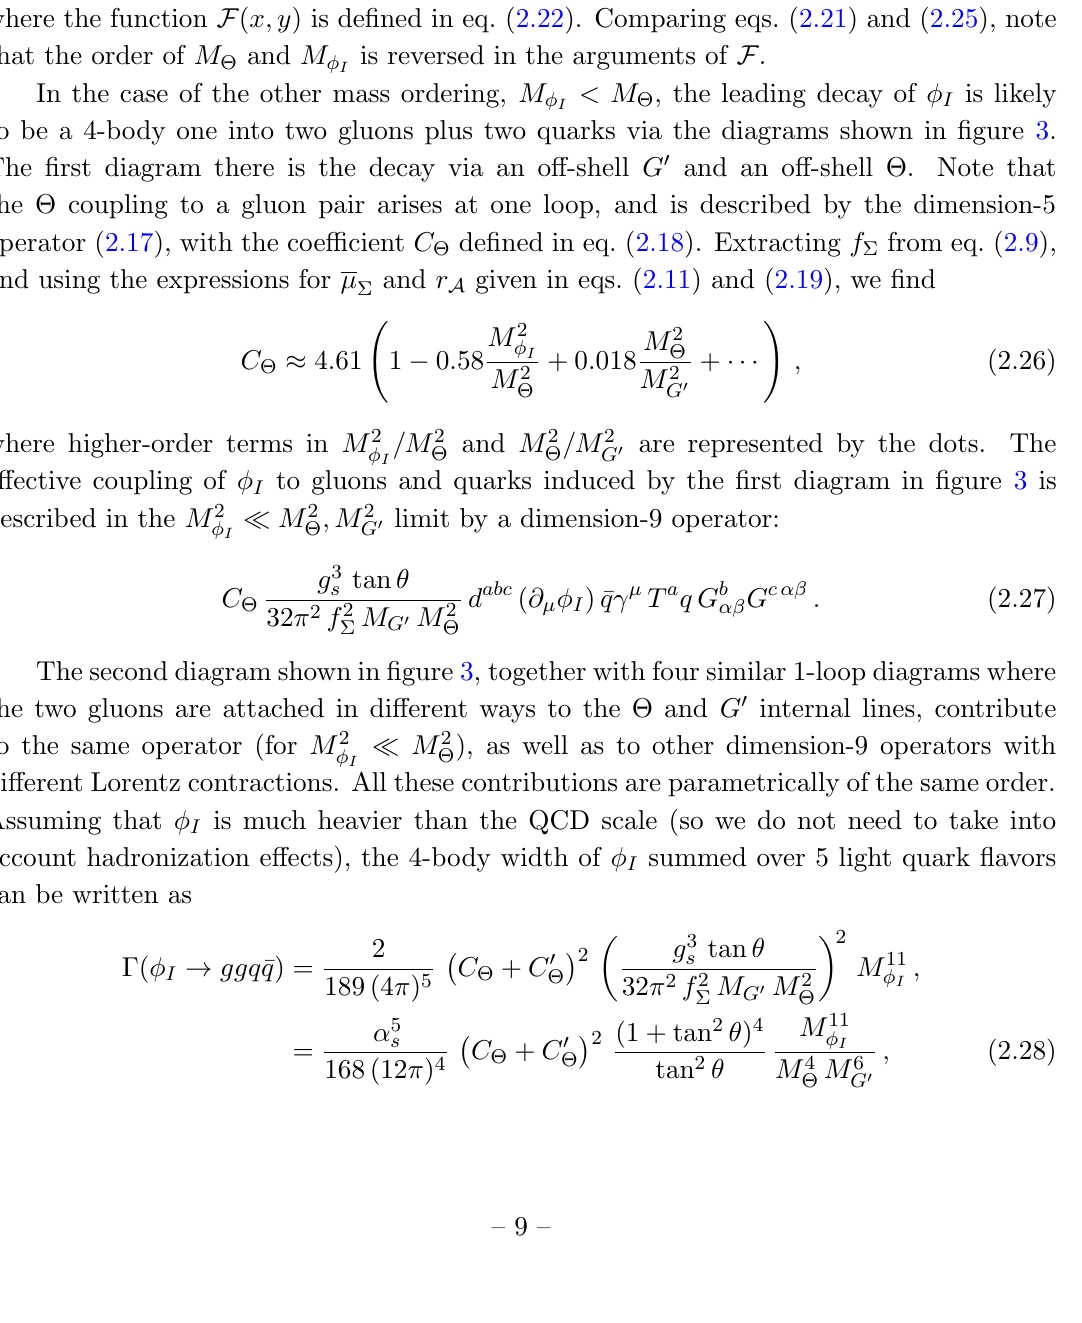
Figure 3 . Diagrams responsible for the 4-body decay (cid:30) M (cid:30) < M (cid:2) . Left diagram: decay through an o(cid:11)-shell coloron and an o(cid:11)-shell (cid:2) scalar, which I couples at one loop to two gluons. Right diagram: 1-loop decay into a gluon pair and an o(cid:11)-shell coloron (other ways of attaching the gluons to the loop are not shown). The coloron interactions with scalars are given in eq.